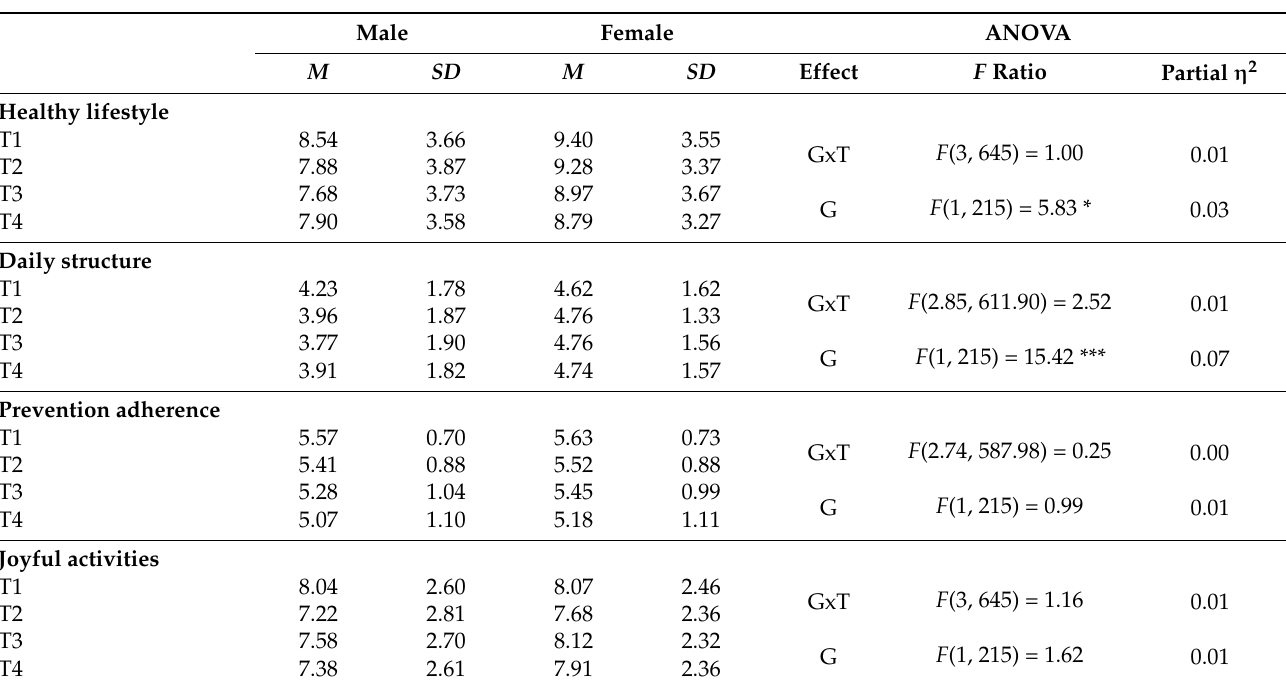
Table 8. Descriptive statistics and two-way ANOVA statistics of pandemic-related coping for males and